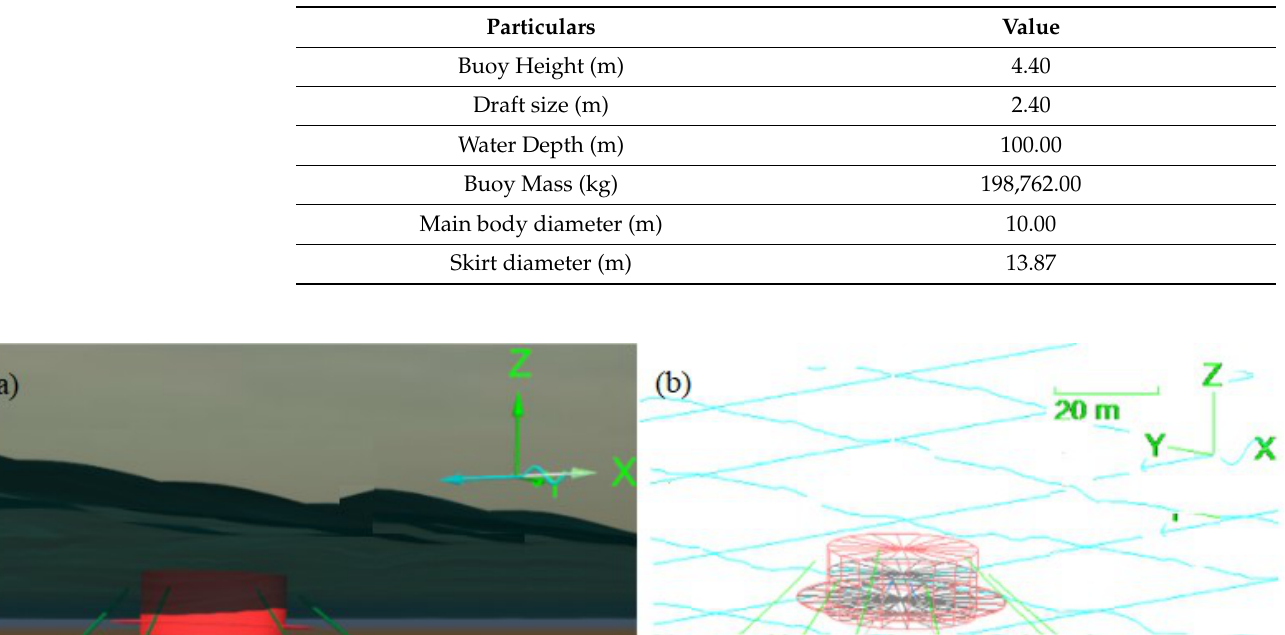
Figure 4. Buoy Design in ANSYS AQWA 2020 R2 showing ( a ) Hydrodynamic Panel, and ( b ) Wave Direction on buoy.